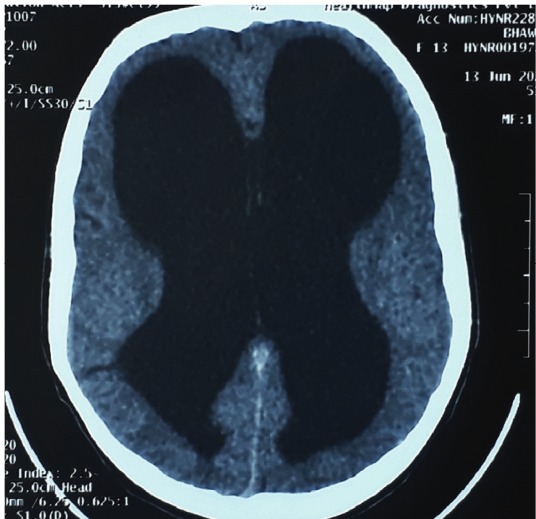
Figure 4: Computed tomography of the brain, axial section showing dilated ventricles suggestive of hydrocephalus.